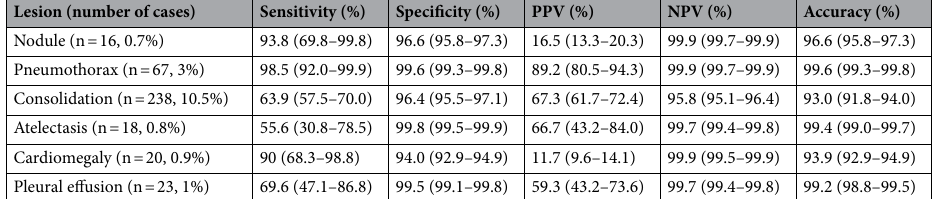
Lesion (number of cases) Sensitivity